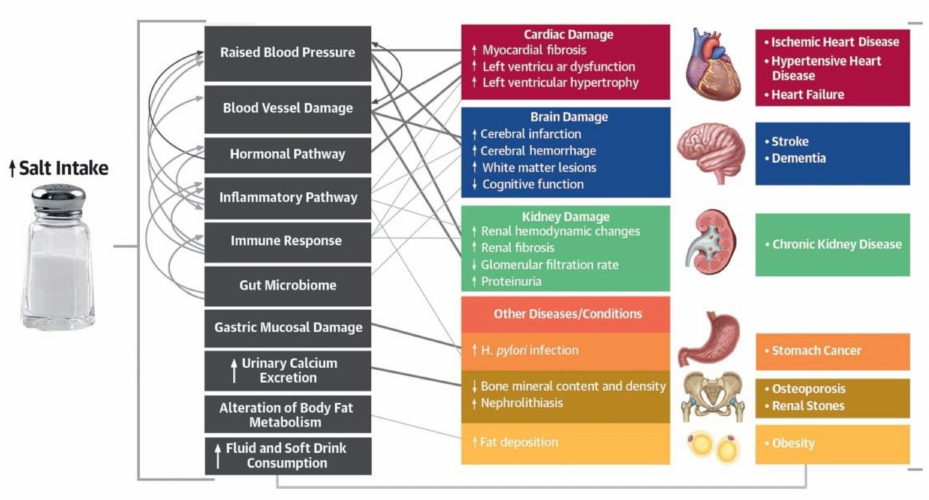
Figure 2. Effect of salt reduction on hypertension adapted from He et al.